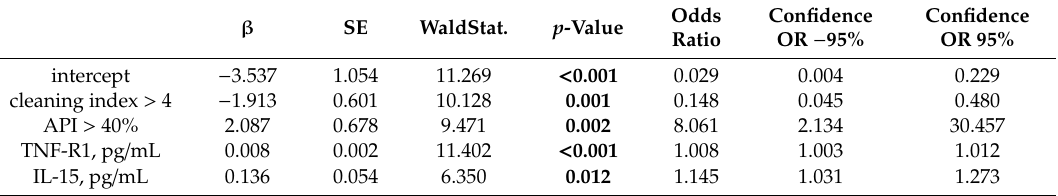
Table 4. Parameters of predictors incorporated into the multivariate logistic regression model, including cleaning index.